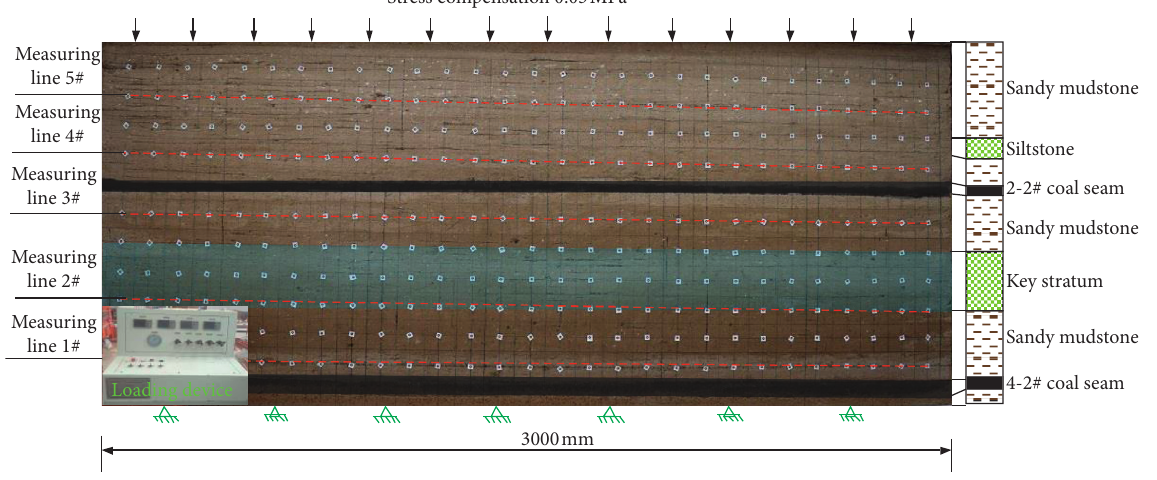
Figure 5: The similar physical Figure 6(a). After the breaking of the key stratum between coal seams 2-2# and 4-2#, there would be a synergistic